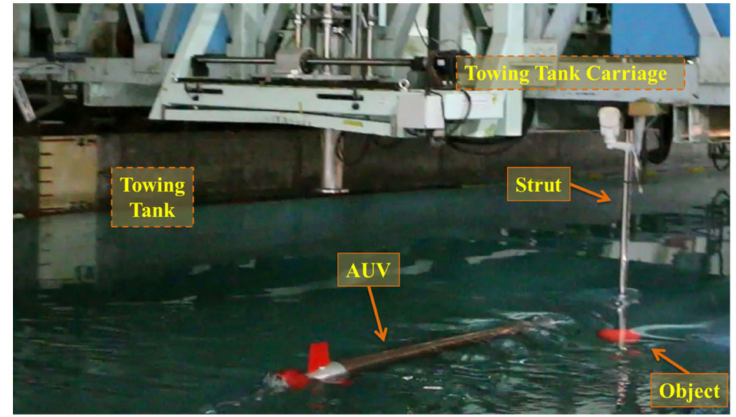
Figure 14. Environment of the dynamic experiment.